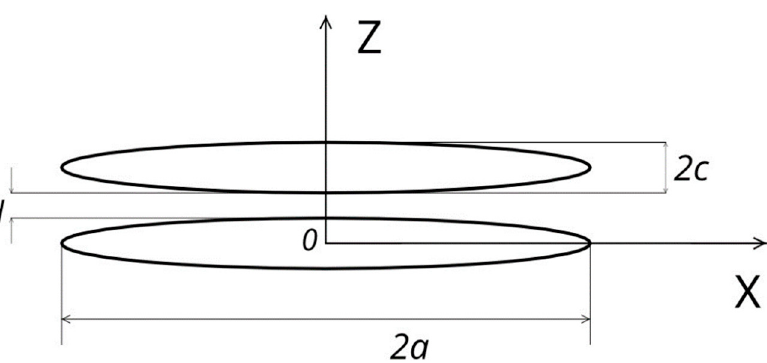
Figure 1. Section of the ellipsoidal magnetic stripes of the magnetic tunnel junction (MTJ) along the X 0 Z coordinate plane.